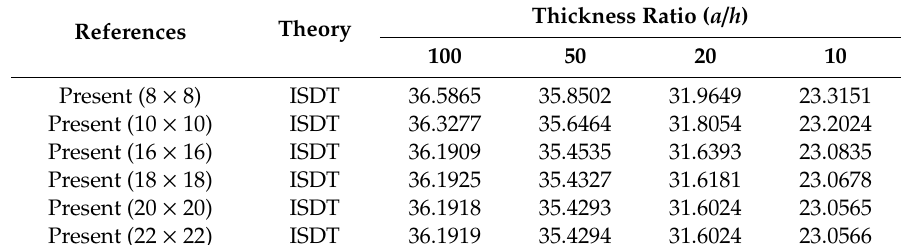
Table 1. Convergence study of nondimensional buckling load with a / h for a simply